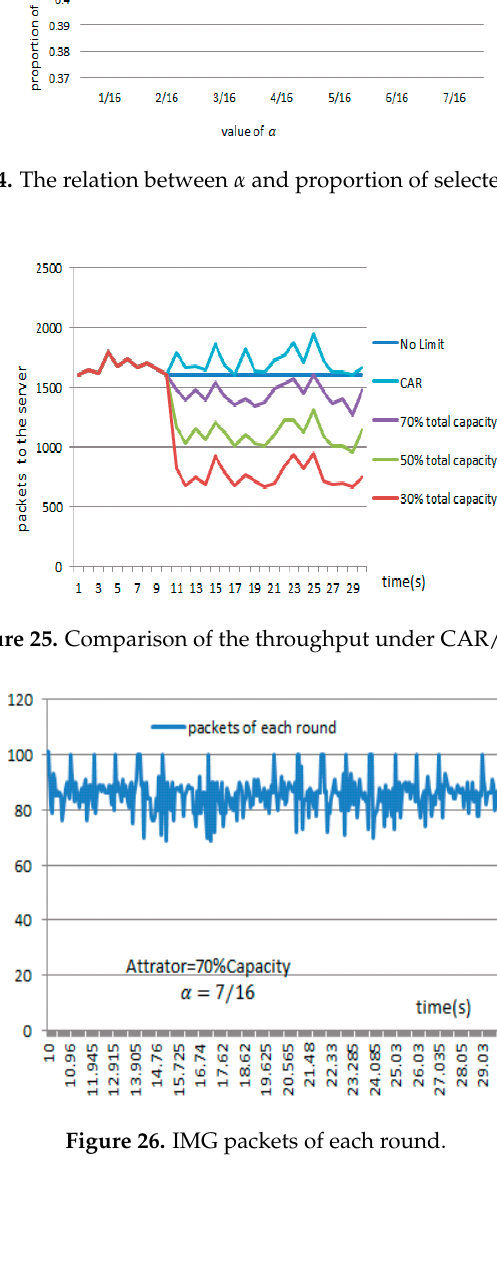
Figure 24. The relation between α and proportion of selected packets.